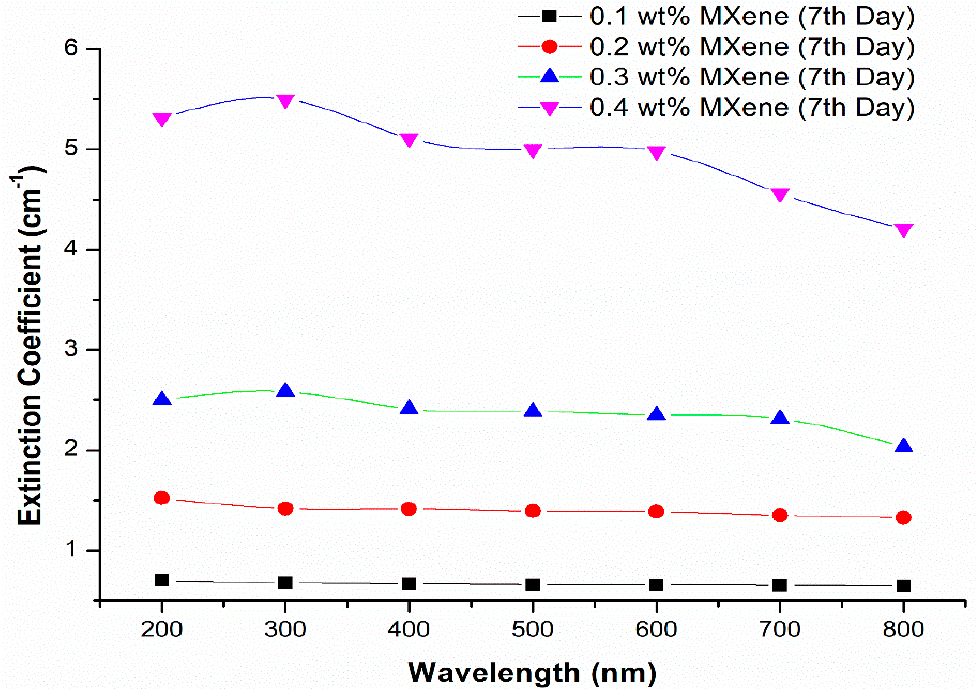
Figure 11. E ff ect of nanoparticle concentration toward extinction coe ffi cient on the seventh day. Figure 11. Effect of nanoparticle concentration toward extinction coefficient on the seventh day.